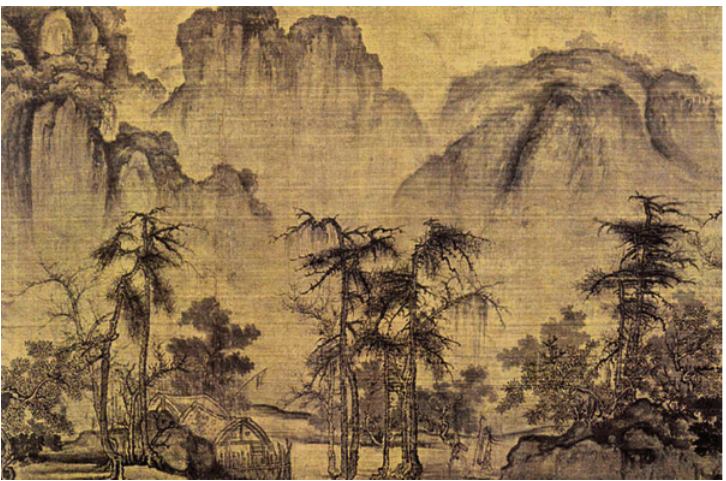
Fig. 5. Guo Xi. Autumn Sky over Mountains and Valley